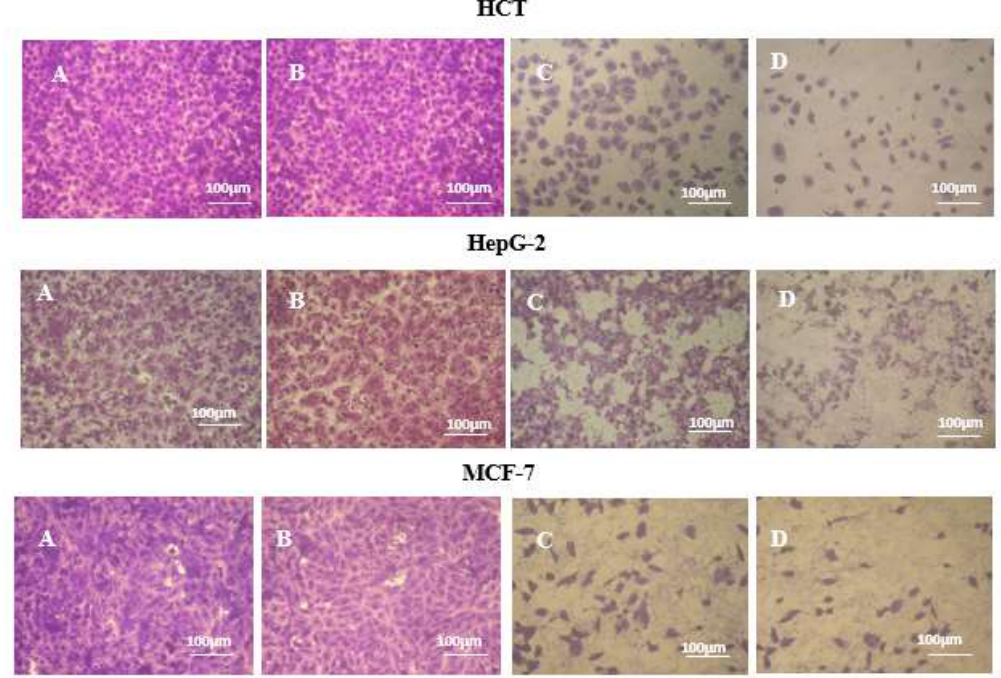
Figure 5. Morphological characteristics of HCT, MCF-7, and HepG-2 cell lines after 24 h of treatment with (15.63 µ g mL − 1 ) of different extracts. The cancer cells were stained with a crystal violet stain. ( A ) Control cells at 24 h, ( B ) E48, ( C ) E20 MPa, ( D ) E10 Magnification: ×20 .